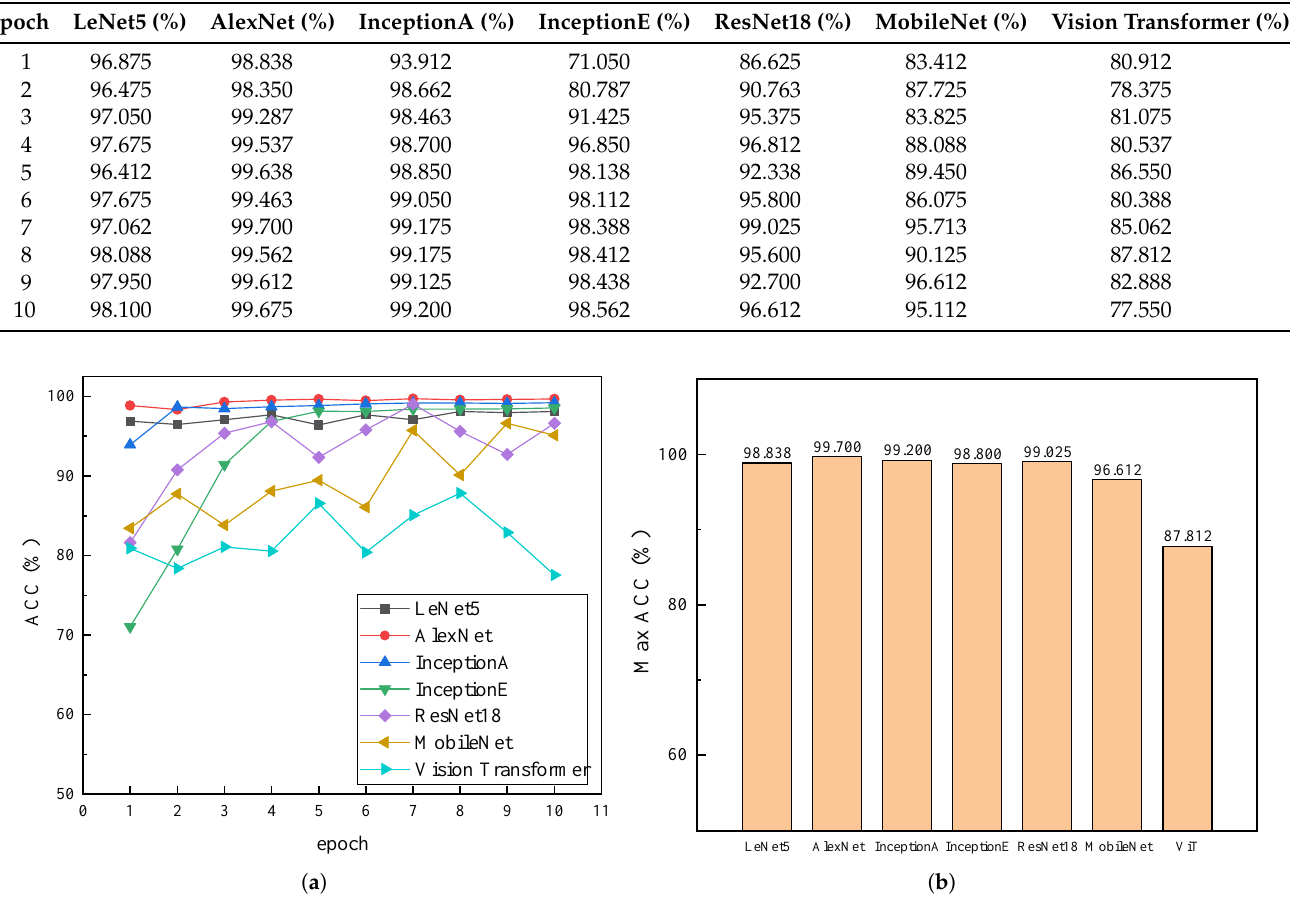
Figure 12. Comparison of accuracy after data augmentation. ( a ) Comparison of accuracy of each model after data augmentation. ( b ) Comparison of the highest accuracy of each model after data